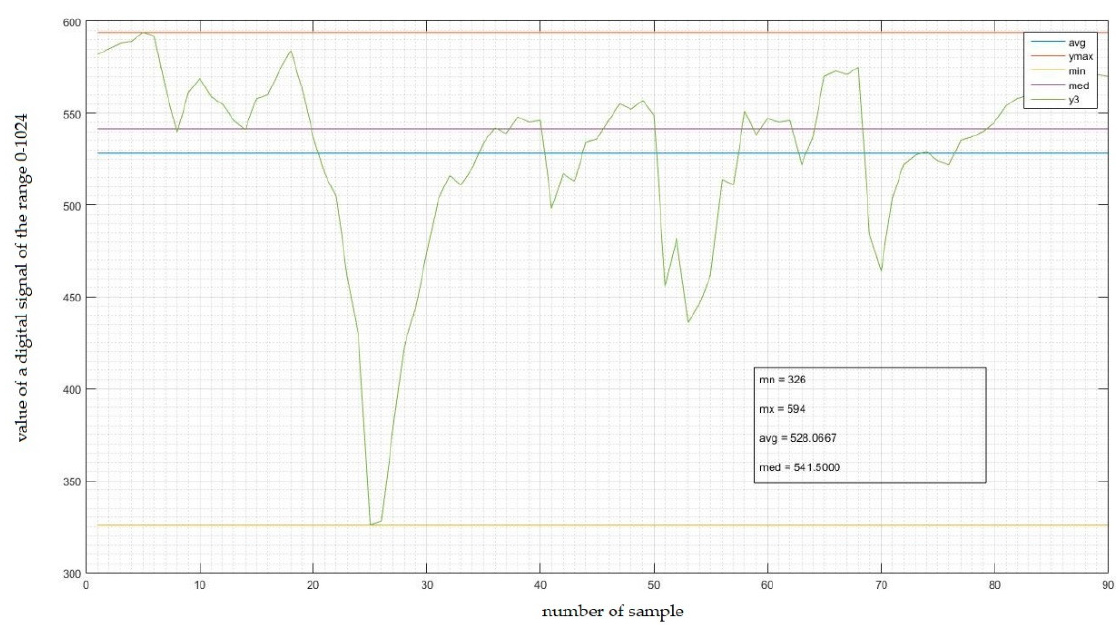
Figure A7. Data from the sensor on a maximally bent ring finger.